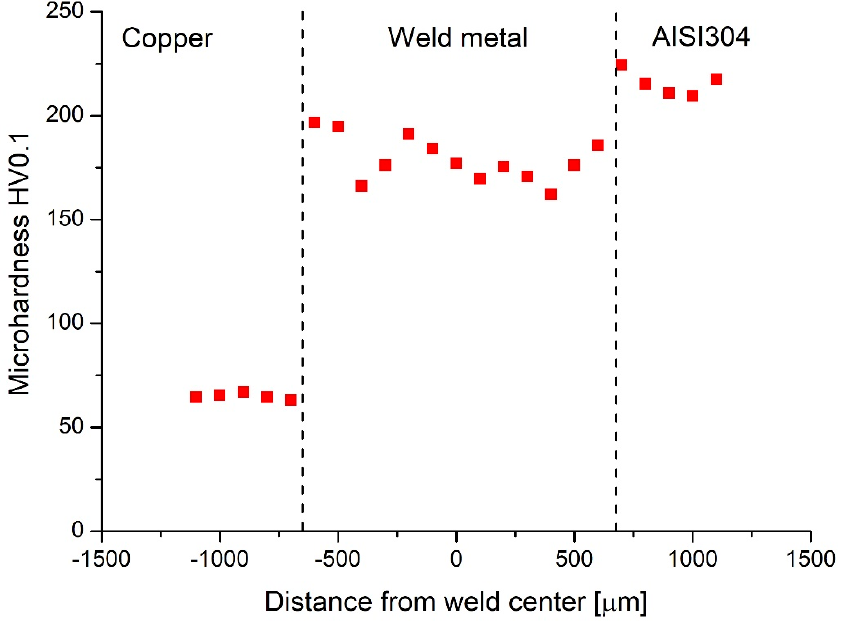
Figure 10. The distribution of microhardness across copper-weld metal-AISI 304 stainless steel interface (weld No. 1).